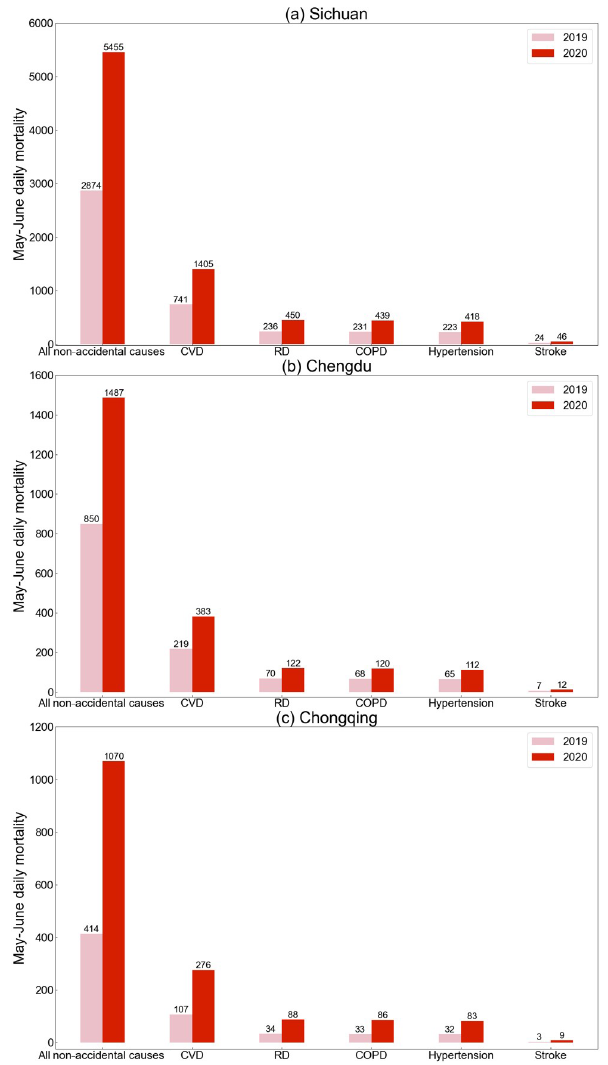
Figure 8. Total daily mortality from all non-accidental causes of death, CVD, RD, COPD, hypertension, and stroke attributable to ambient O 3 exposure over the SCB during May–June in 2019 and